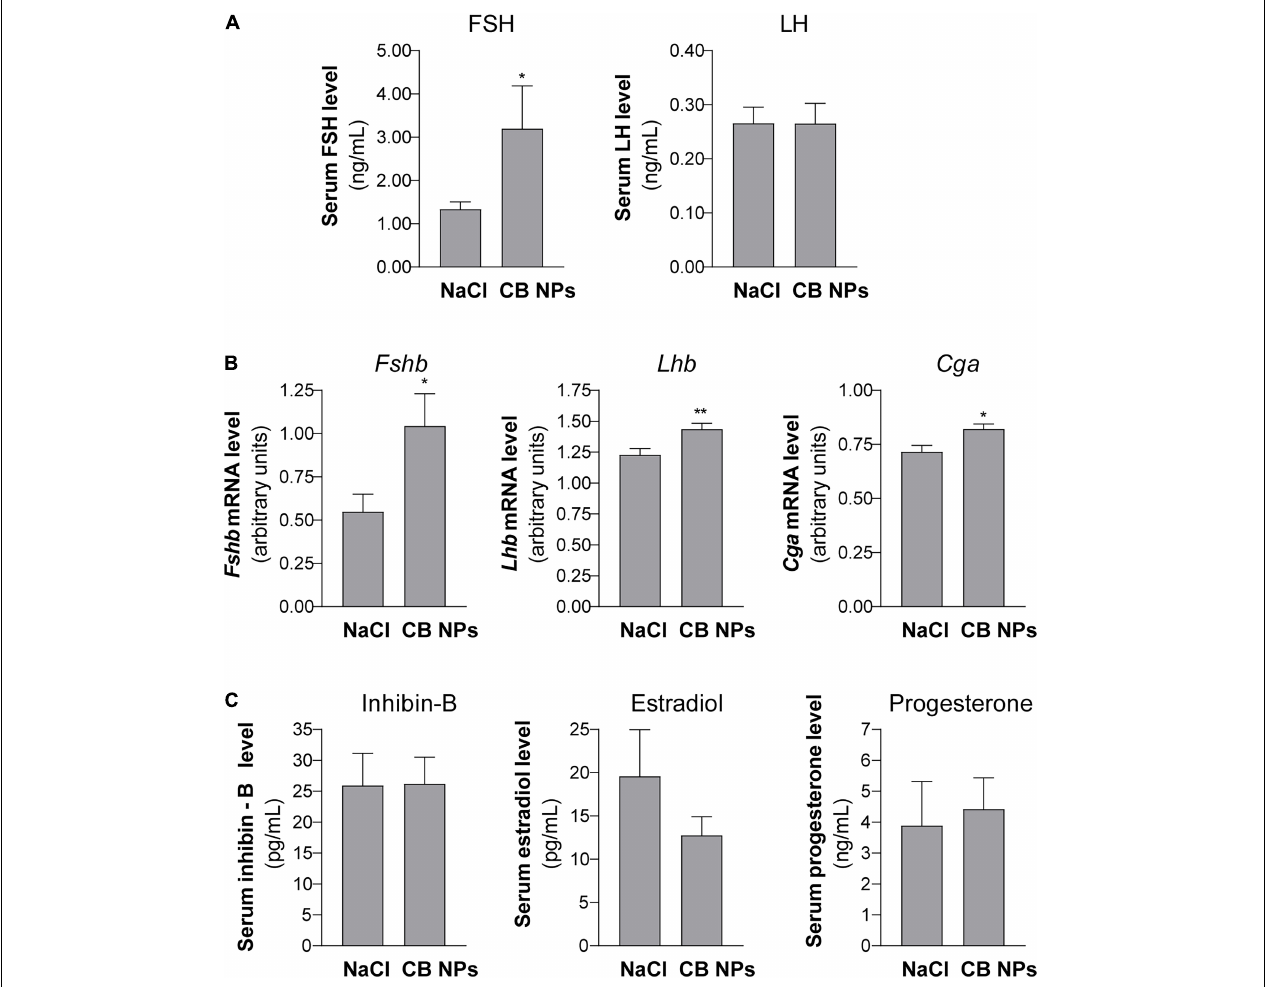
FIGURE 2 | Pituitary gonadotropin serum levels and subunit gene expression in female mice exposed to CB NPs. CB NPs (100 µ g) or control saline solution (NaCl, 0.9%) were intratracheally administered to C57BL/6 mice once a week during four weeks as described in the Materials and Methods. Mice were sacrificed and anterior pituitaries and blood were collected. Concentrations of FSH and LH were determined in serum by Luminex technology in 24 NaCl- and 33 CB NP-treated mice (A) . Fshb , Lhb and Cga mRNA levels were determined by real-time quantitative PCR in 24 NaCl- and 33 CB NP-treated mice (B) . Serum levels of inhibin B and sex steroids (estradiol and progesterone) were determined by ELISA and GC-MS, respectively, as described in the materials and methods (C) . Assays were performed on 23 NaCl- and 30 CB NP-treated mice for inhibin-B, 11 NaCl- and 18 CB NP-treated mice for estradiol and 16 NaCl- and 24 CB NP-treated mice for progesterone. Data are represented as mean ± SEM. Statistical differences were determined by the Unpaired t -test (for B, Fshb mRNA) or Mann-Whitney test. * p < 0.05 and ** p < 0.01 compared to